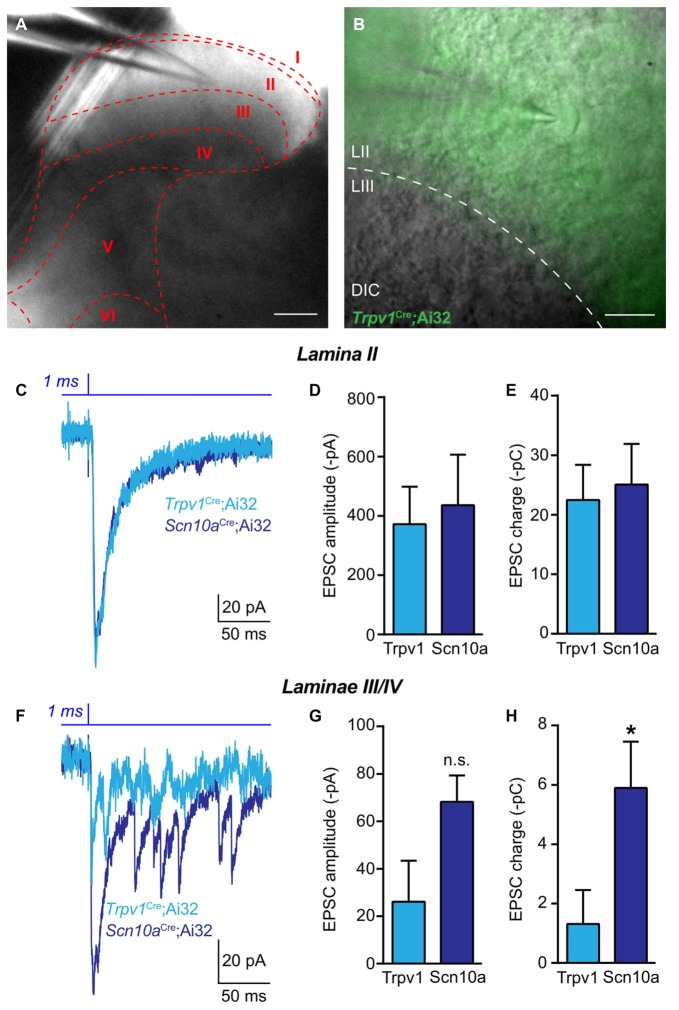
Spinal functional connectivity in Trpv1Cre;Ai32 and Scn10aCre;Ai32 mice. (A,B) Representative images showing location of recording electrode in spinal cord slice from Trpv1Cre;Ai32 mice. (C) Representative traces recorded during optogenetic activation of excitatory synaptic transmission from ChR2+ primary afferents in voltage clamp recordings from laminae I-II in Trpv1Cre;Ai32 and Scn10aCre;Ai32 mice. (D,E) In Trpv1Cre;Ai32 and Scn10aCre;Ai32 mice, there was no significant difference in the amplitude of EPSCs or charge transfer (P > 0.05, unpaired t-test; n = 9 cells for Trpv1Cre;Ai32 and n = 5 cells for Scn10aCre;Ai32). (F) Representative traces of excitatory synaptic currents during voltage clamp recordings from laminae III/IV in Trpv1Cre;Ai32 and Scn10aCre;Ai32 mice. (G) There was no significant difference between in the amplitude of excitatory currents. (H) In spinal laminae III/IV of Scn10aCre;Ai32 mice, a significant increase in charge transfer was observed compared to Trpv1Cre;Ai32 mice (*P < 0.05, unpaired t-test; n = 7 cells for Trpv1Cre;Ai32 and n = 6 cells for Scn10aCre;Ai32).